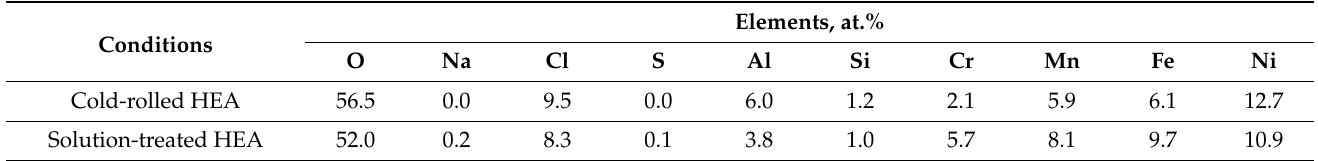
Table 4. EDX analysis of the corrosion products on the surface of cold-rolled and